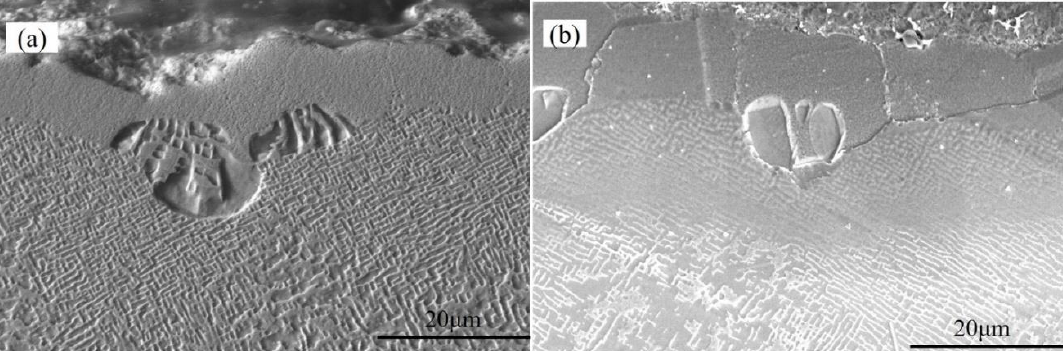
Figure 5. Specimen recrystallization morphology at 0.5 MPa sandblasting pressure in ( a ) uncoated and ( b ) coated alloys .